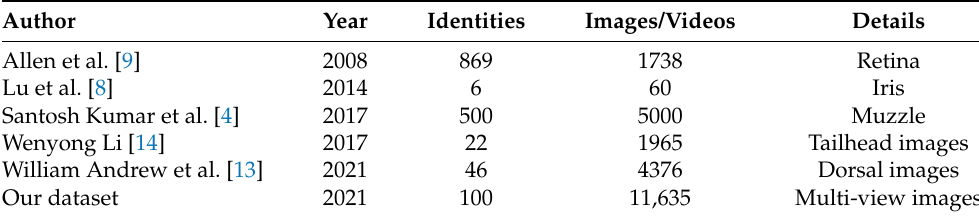
Table 1. Datasets for visual cattle identification.